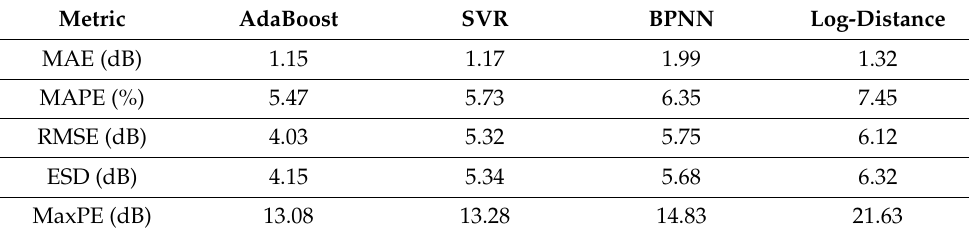
Table 1. Performance evaluation of various models using 20% test samples from Orange FM (94.5 MHz) Base